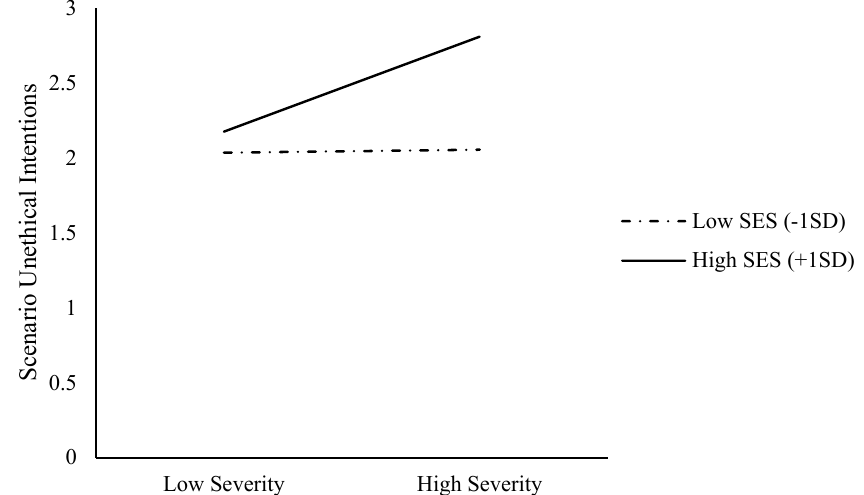
Figure 3 . Unethical intention scenarios as functions of epidemic severity and SES (Study 2).